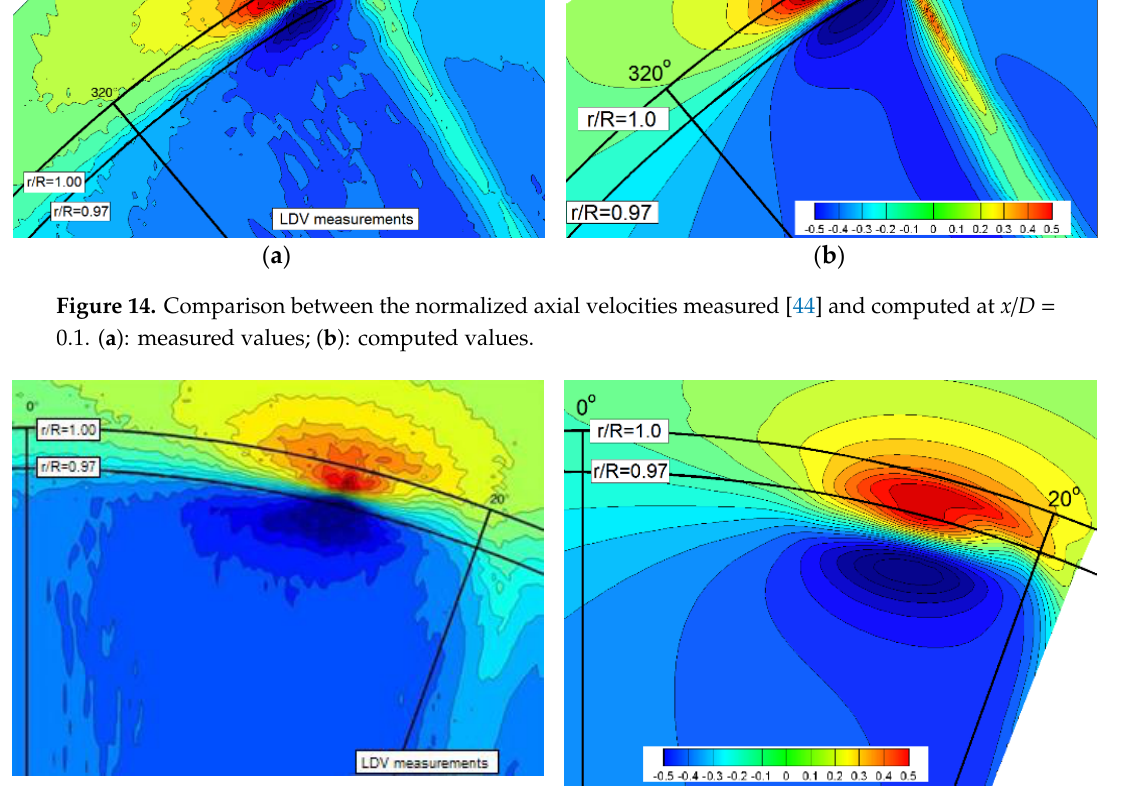
Figure 15. Comparison between the normalized axial velocities measured [44] and computed at x / D =0.2. ( a ): measured values; ( b ): computed values.